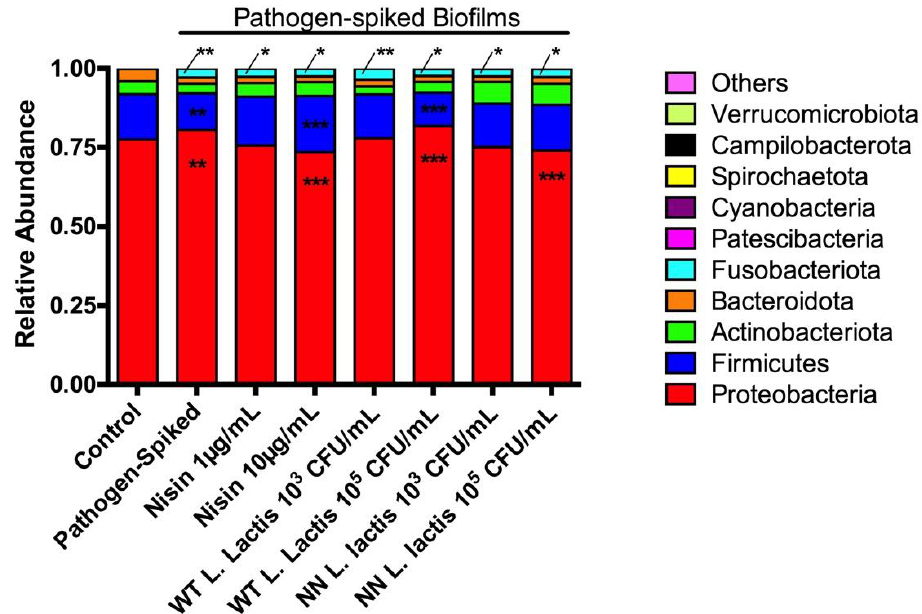
Figure 5. Lower doses of nisin and probiotic revert Proteobacteria and Firmicutes phyla back to control levels. Top 10 phyla relative abundance are displayed; * means p ≤ 0.05; ** means p ≤ 0.01, *** means p ≤ 0.001 between the marked sample and control.